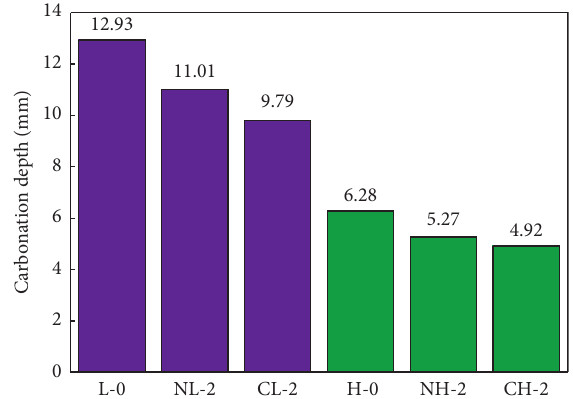
Figure 14: Carbonation depth of concrete with LDHs at